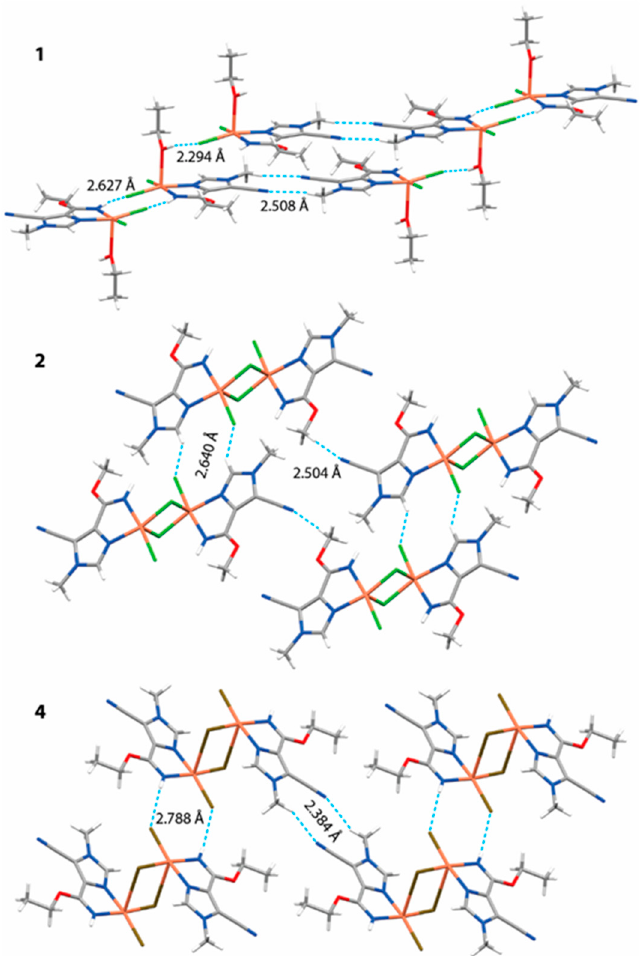
Figure 4. Packing in solid state for 1 , 2 , and 4 . 2 and 3 have a similar type of